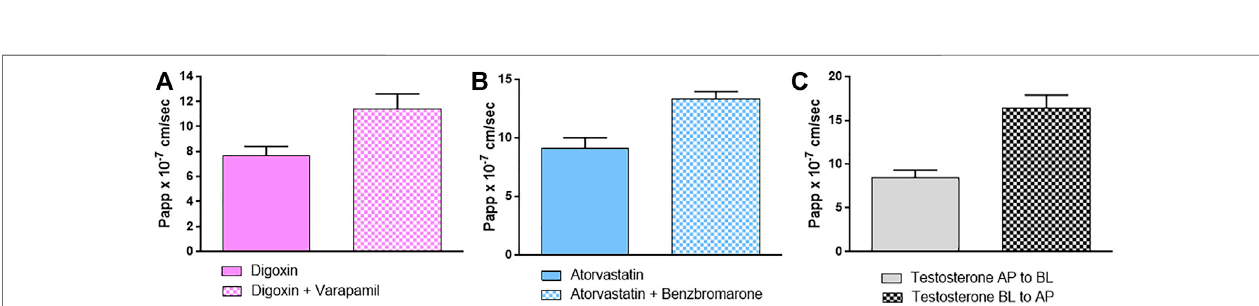
FIGURE 2 | Papp (AP-BL) values of: MC-RR, MC-YR, MC-LR, MC-LW and MC-LF at 20 µM (closed bar) and e 40 µM (open bar). MCs order was based on increasinglipophycility (Santorietal.,2020).Atleasttwoindependent experiments ondifferenttissuelots fromthesamedonorhave beencarried outeach induplicates. Results are expressed as means ± standard deviations.